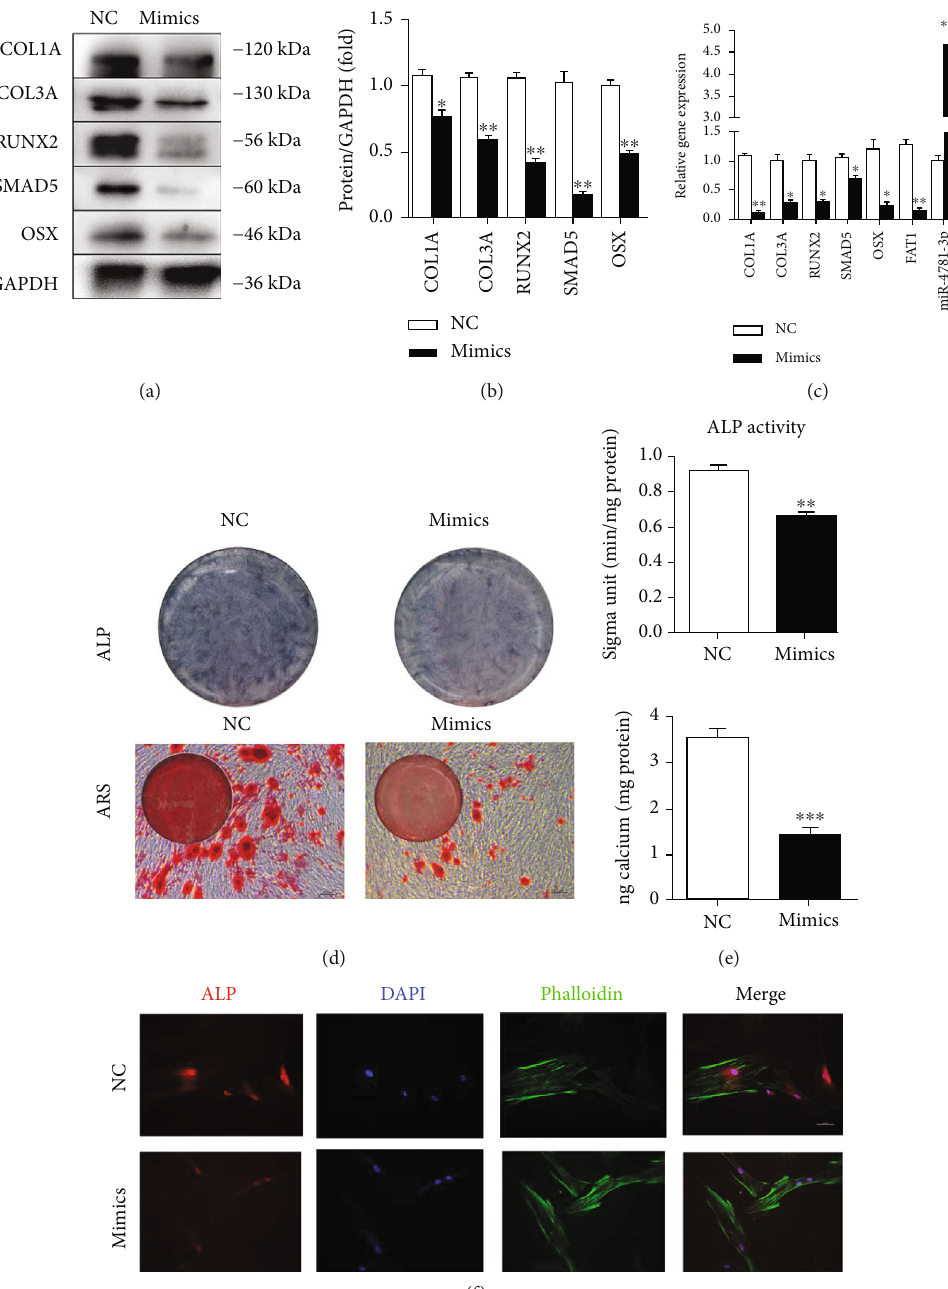
Figure 5: Overexpression of miR-4781-3p decreases osteoblastic di ff erentiation tendency of PDLSCs. (a) – (c) The results of Western blot and RT-qPCR showed SMAD5 and osteogenic markers (RUNX2, OSX, COL1A, and COL3A) were downregulated in miR-4781-3p mimic transfected PDLSCs (mimics group). In addition, RT-qPCR results showed that the expression of circFAT1 was downregulated, and miR-4781-3p was upregulated in the mimics group. (d, e) Overexpression of miR-4781-3p reduced the ALP activity of PDLSCs 7 days after osteogenic induction. ARS showed the mineralization of PDLSCs was decreased signi fi cantly in the mimic group after osteogenic induction for 14 days. (f) Immuno fl uorescence experiments con fi rmed the decreased expression of ALP in the mimics group. ∗ P < 0 : 05 , ∗∗ P < 0 : 01 , and ∗∗∗ P < 0 : 001